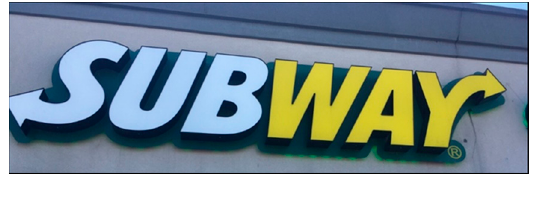
Table 5. Coding example using the teen-developed tool: Advertisement A.